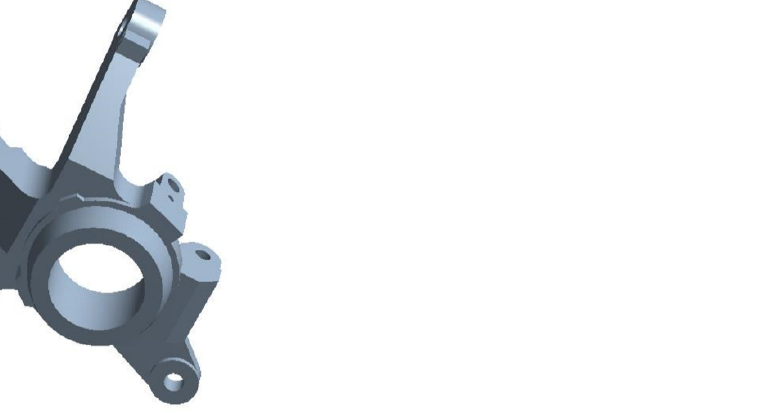
Figure 7. A corrected version of the steering knuckle geometry (smooth model) [13].